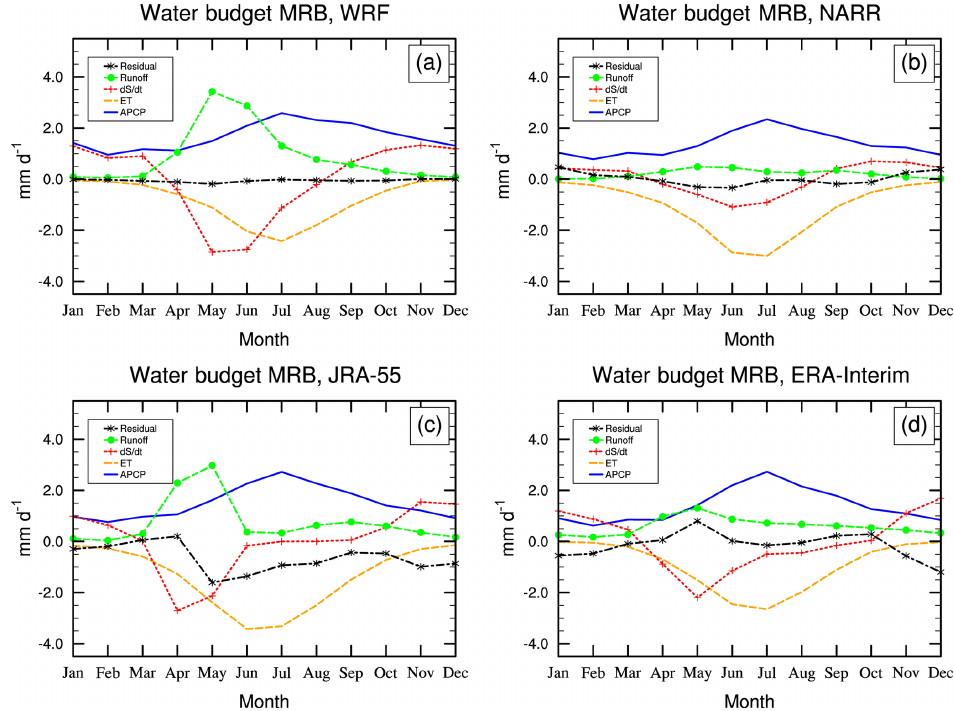
Figure 2. The surface water budget (mmd − 1 ) in MRB from WRF–CTL and the reanalysis datasets (NARR, ERA-Interim, and JRA-55). ET denotes evapotranspiration. APCP denotes accumulated precipitation per time interval.